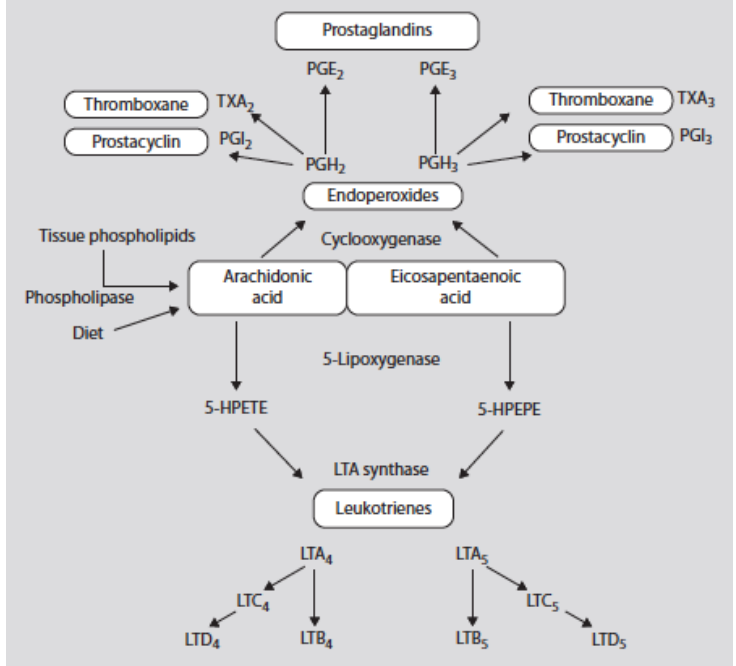
Figure 2. Oxidative metabolism of arachidonic acid (AA) and eicosapentaenoic acid by the cy ‐ clooxygenase and 5 ‐ lipoxygenase pathways. 5 ‐ HPETE denotes the 5 hydroperoxyeicosatetranoic acid and 5 ‐ HPEPE denotes the 5 ‐ hydroxyeicosapentaenoic acid [3].